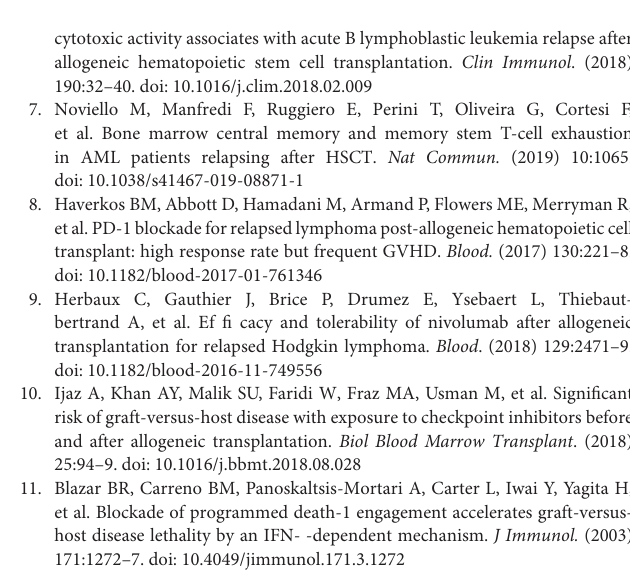
Supplemental Figure 1 | Perforin and Granzyme B expression in PD-1 + and PD-1- CD8T cells. Proportions of perforin (left panels) and granzyme B (right panels) expressing cells among PD-1 + and PD-1- CD8T cells (A) and CD8T cell subsets (B–D) from HC (white filled dots) or HSCT recipients (black filled dots). The p -values are indicated when significant (Wilcoxon signed-rank test). Supplemental Figure 2 | Impact of different immunosuppressive drugs for GvHD prophylaxis on PD-1 expression on CD4 and CD8T cells after allogeneic HSCT. Comparison of PD-1 expression on CD4 ( Upper Panel ) and CD8 ( Lower Panel ) T cells from HSCT recipients receiving the indicated GvHD prophylaxis. The p -values resulting from the multivariable linear regression analysis are indicated when